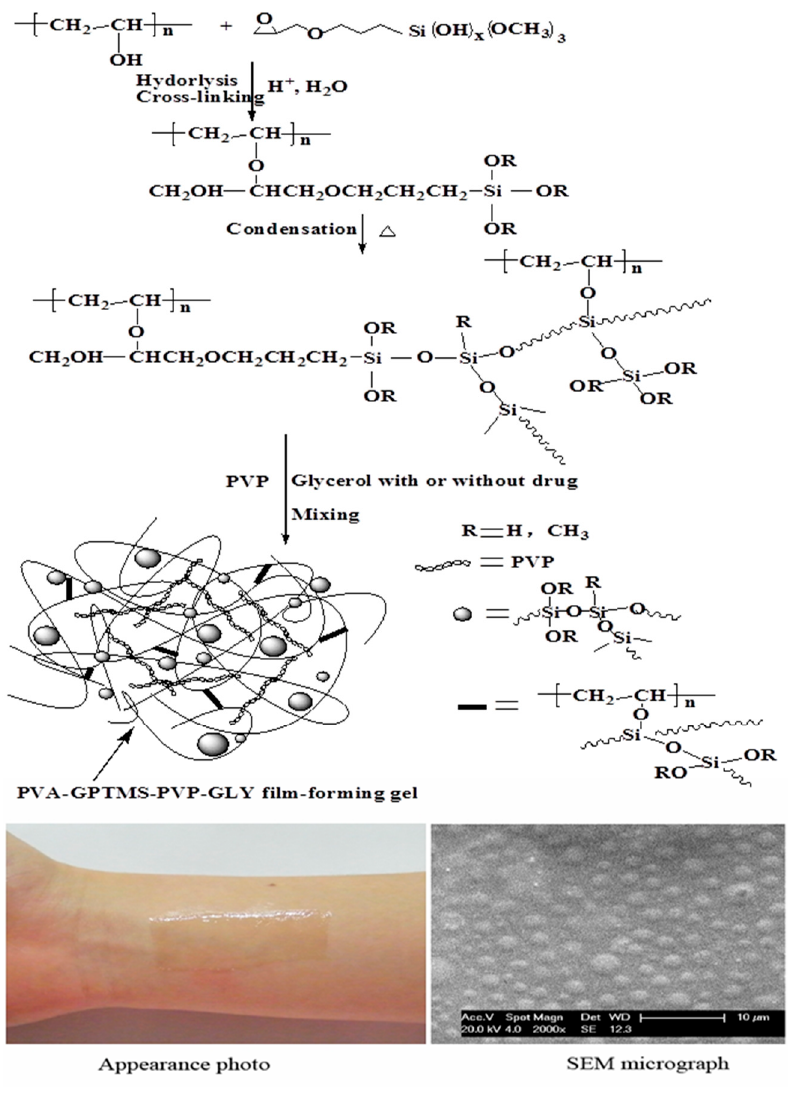
Figure 6. Illustration of the preparation of PVA-GPTMS-PVP-GLY film-forming gel and the appearance photo and SEM micrograph of the resultant gel, reproduced with permission from [69]. Copyright Elsevier,